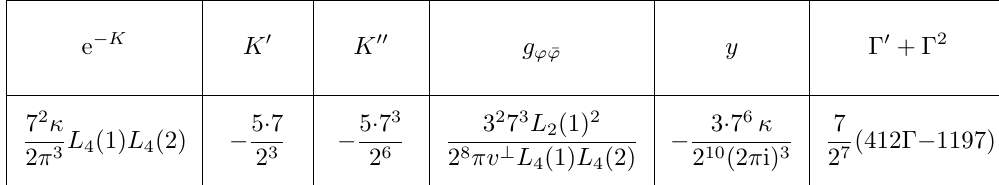
Table 6 . The values of quantities that enter into the calculation of the covariant derivatives of table 5. In this table, (cid:0) denotes the Christo(cid:11)el symbol (cid:0) ’ . ’’ (cid:3)